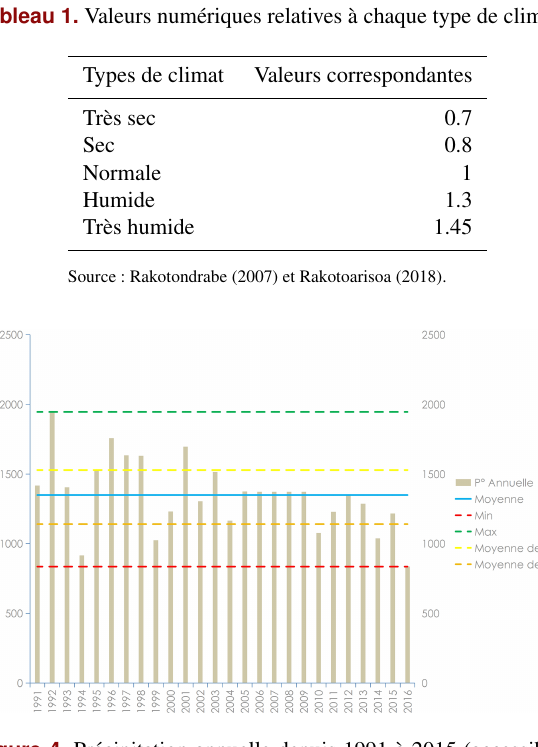
Figure 4. Précipitation annuelle depuis 1991 à 2015 (accessible à l’adresse suivante : https://climateknowledgeportal.worldbank.org/ download-data, la date du dernier accès : 18 octobre 2021).